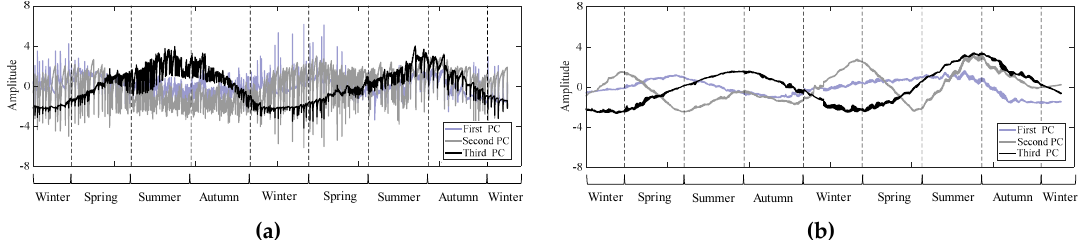
Figure 3. First, second, and third PC time-series of six decomposed variables extracted from ( a ) pt. 1 (near the sea-dike) and ( b ) pt. 38 (ocean side).